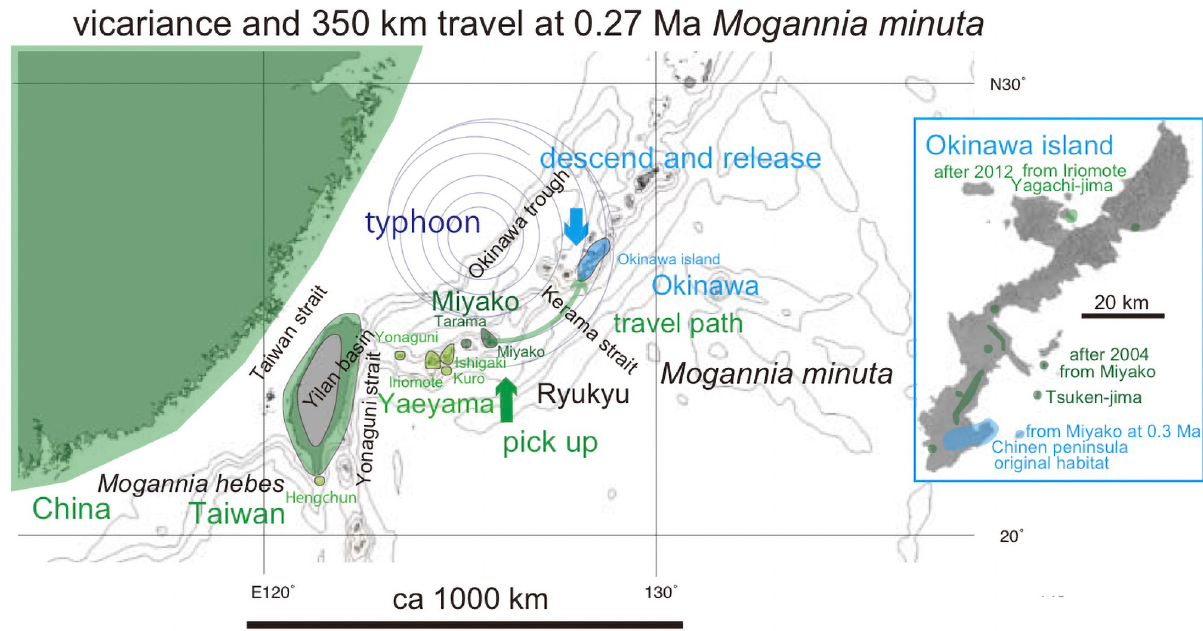
Fig 2. Distribution of Mogannia . Island populations are shown by color highlights. See Discussion; Green anticlockwise curved track: Typhoon dispersal at 0.27 Ma from Miyako (green) to Okinawa (blue). The bold short arrows schematically (not to scale) show where the typhoon winds picked up cicada (green) and where the same cicada were released (blue). Inset: Original habitat in the southern Okinawa and new habitats (blue). We clarified that only the Yagachi-jima population (green) has the same COI sequence with the southern Iriomote-jima, Yaeyama, and dispersed from there. Base map from Vector Map (VMap) Level 0, National Geospatial-Intelligence